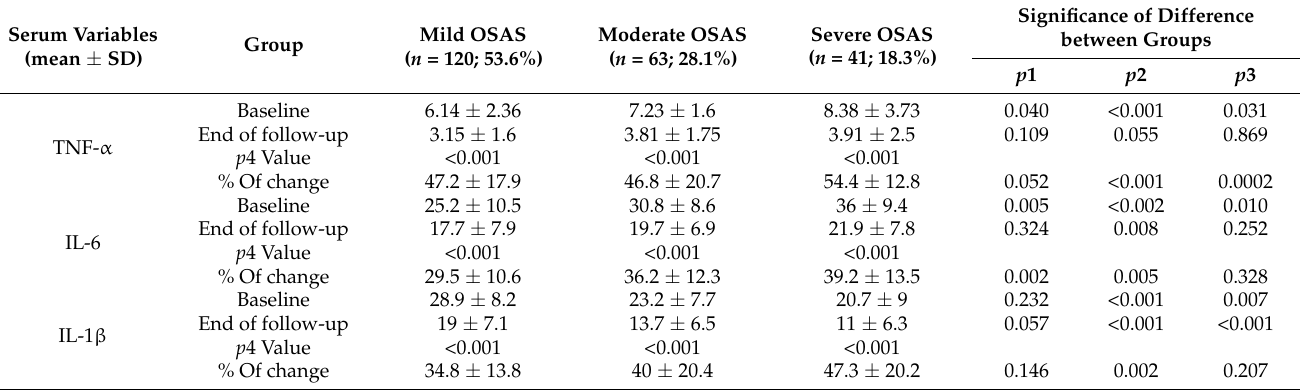
Table 3. Serum levels of studied cytokines that were estimated at time of enrolment and at the end of the follow-up of patients categorized according to OSAS